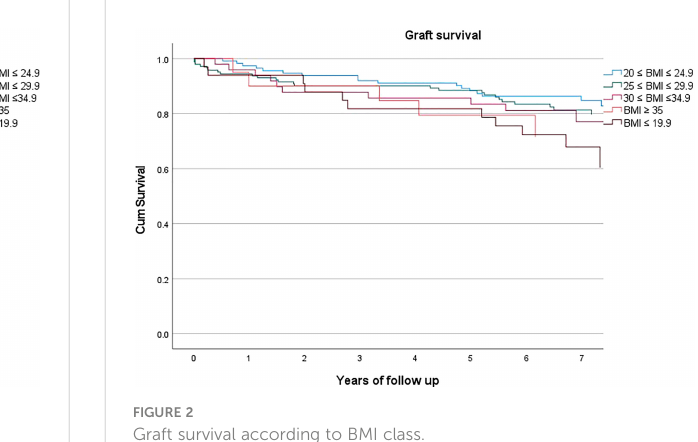
FIGURE 2 Graft survival according to BMI